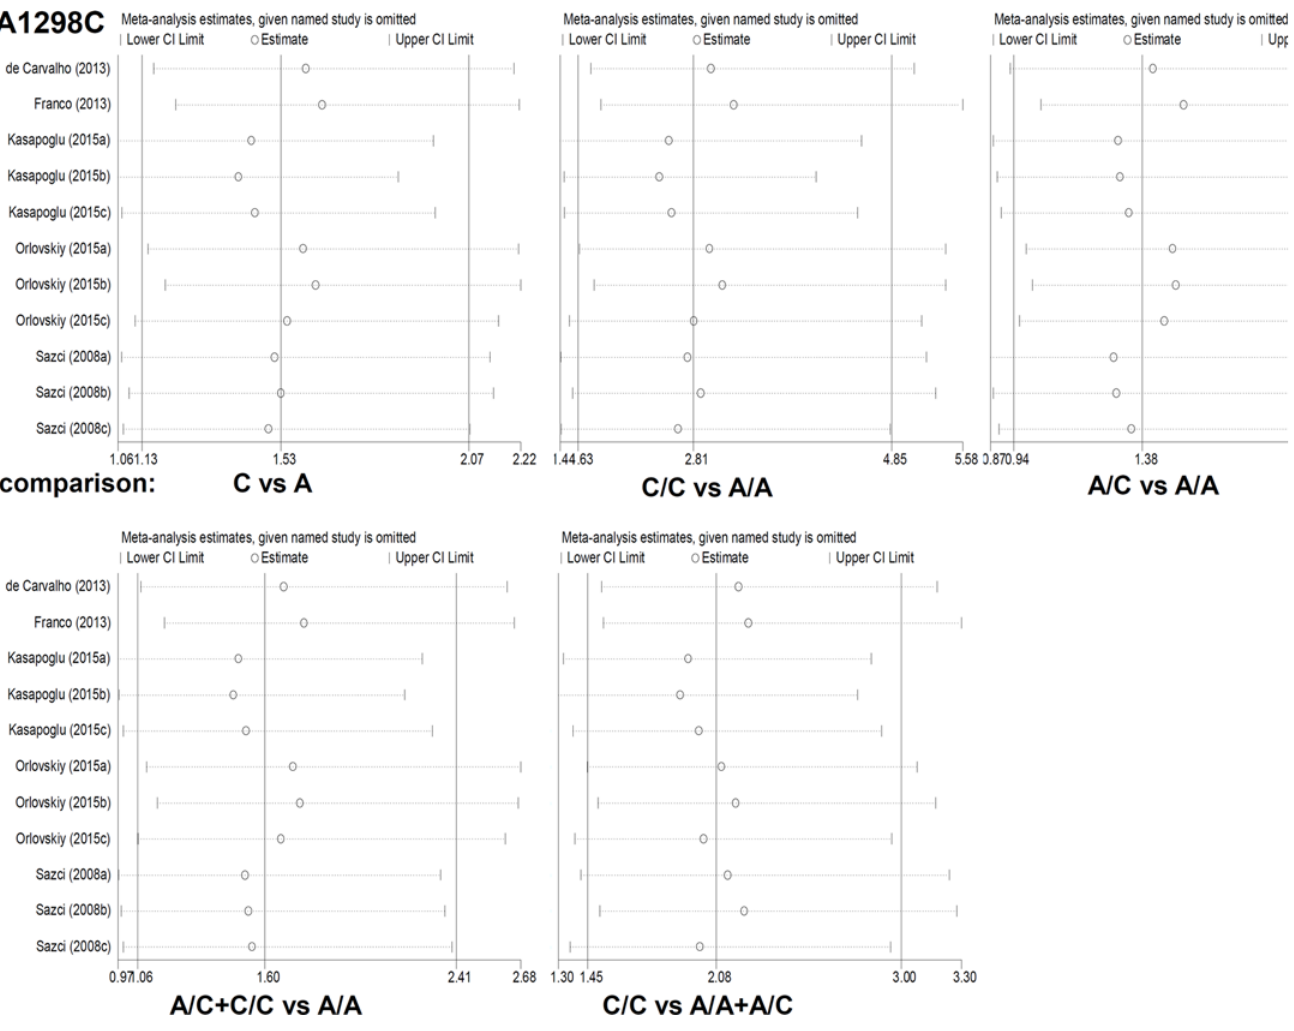
Fig 5. The sensitivity meta-analyses for the association between A1298C polymorphism of MTHFR and the risks of